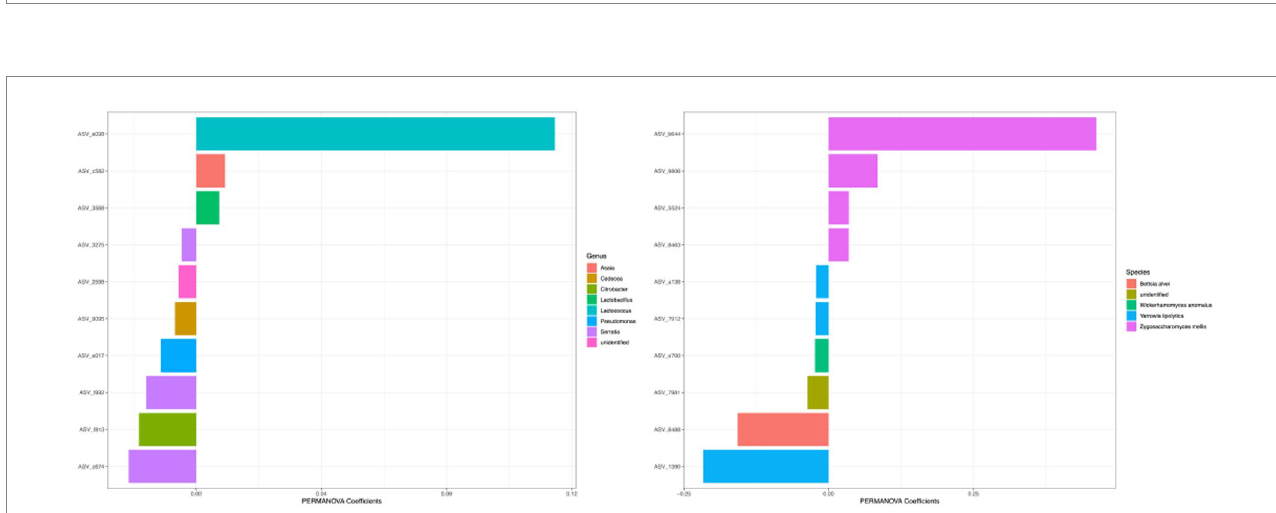
FIGURE 9 Top coefficient amplicon sequence variants (ASVs) for beta diversity. Top bacterial and fungal ASVs that were associated with community differences between samples as estimated by Bray–Curtis dissimilarity were plotted. Color of each bar represented the genera for 16S ASVs and species for ITS ASVs. The top 10 ASVs with the highest PERMANOVA coefficient values were